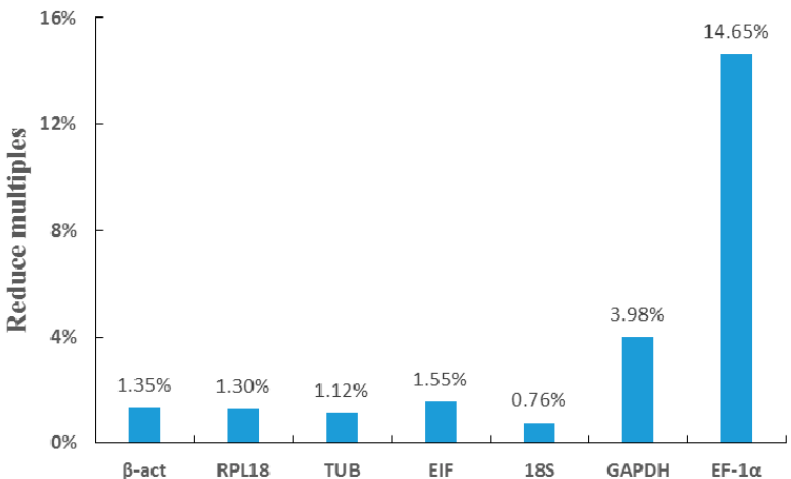
Figure 7. Using different genes as the reference gene for the reduce multiples of the SST gene expression, relative to the original level after interference.